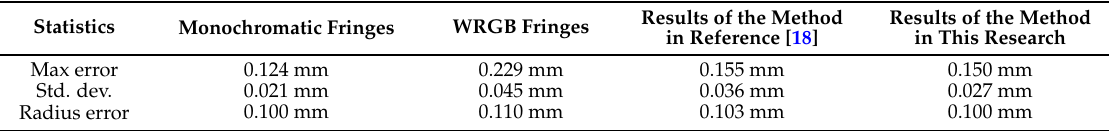
Figure 15. Measurement results of a standard ball: 3D point clouds using ( a ) monochrome fringe; ( b ) color fringe pattern without correction; ( c ) the method in Reference [18]; ( d ) the proposed method; measurement error using ( e ) monochrome fringe; ( f ) color fringe pattern without correction; ( g ) the method in Reference [18]; ( h ) the proposed method. Table 2. Statistic of the measurement error of a standard ball.